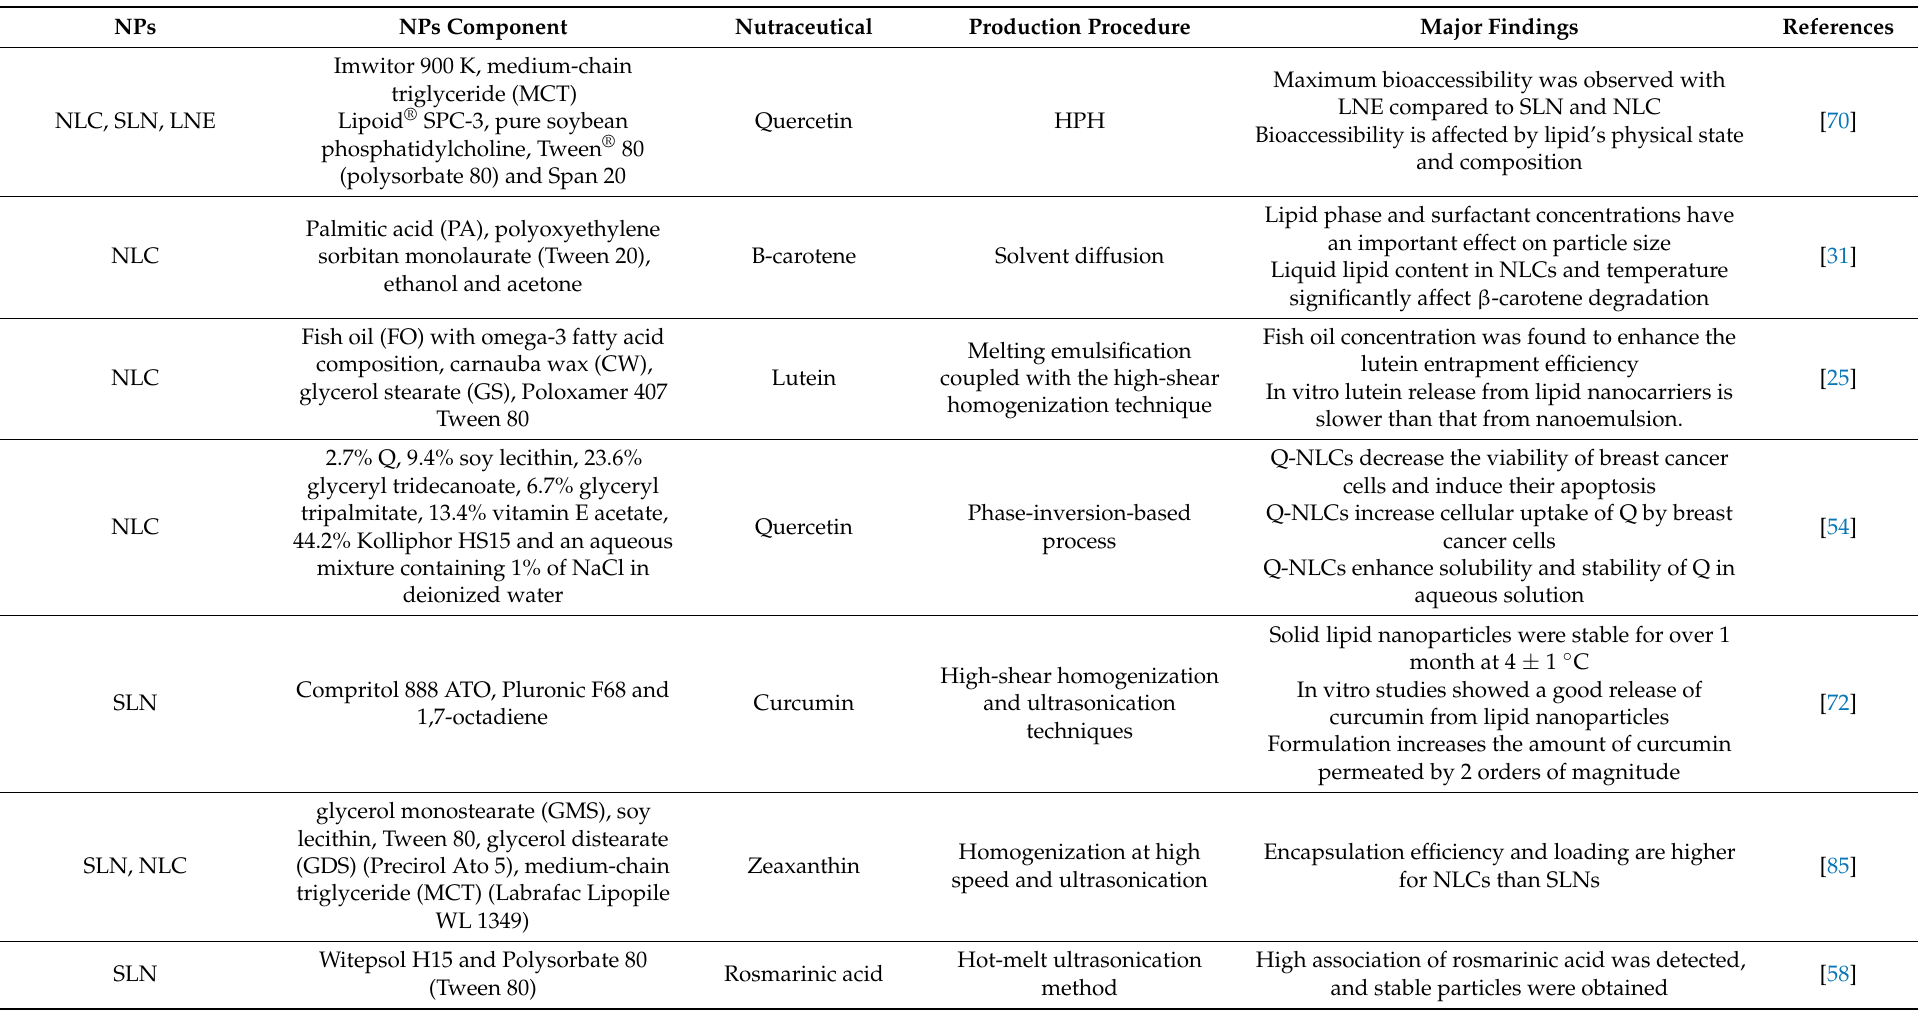
Table 2. Overview of the recent works on nanoparticles containing nutraceuticals: Type of nanoparticles (NPs), NP components, bioactive compound encapsulated and production procedure employed are